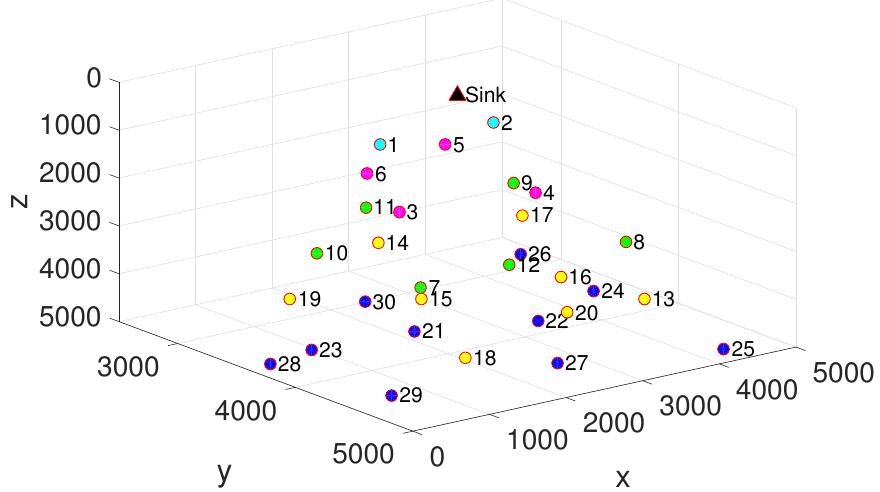
Figure 12. Sparse topology of 30 underwater transmission